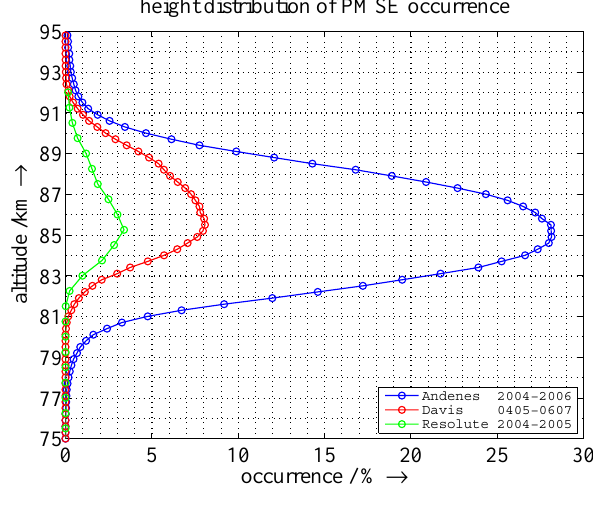
Fig. 12. Height distribution of PMSE occurrence above Andenes (2004–2006, blue), Davis (0405–0607, red) and Resolute (2004–